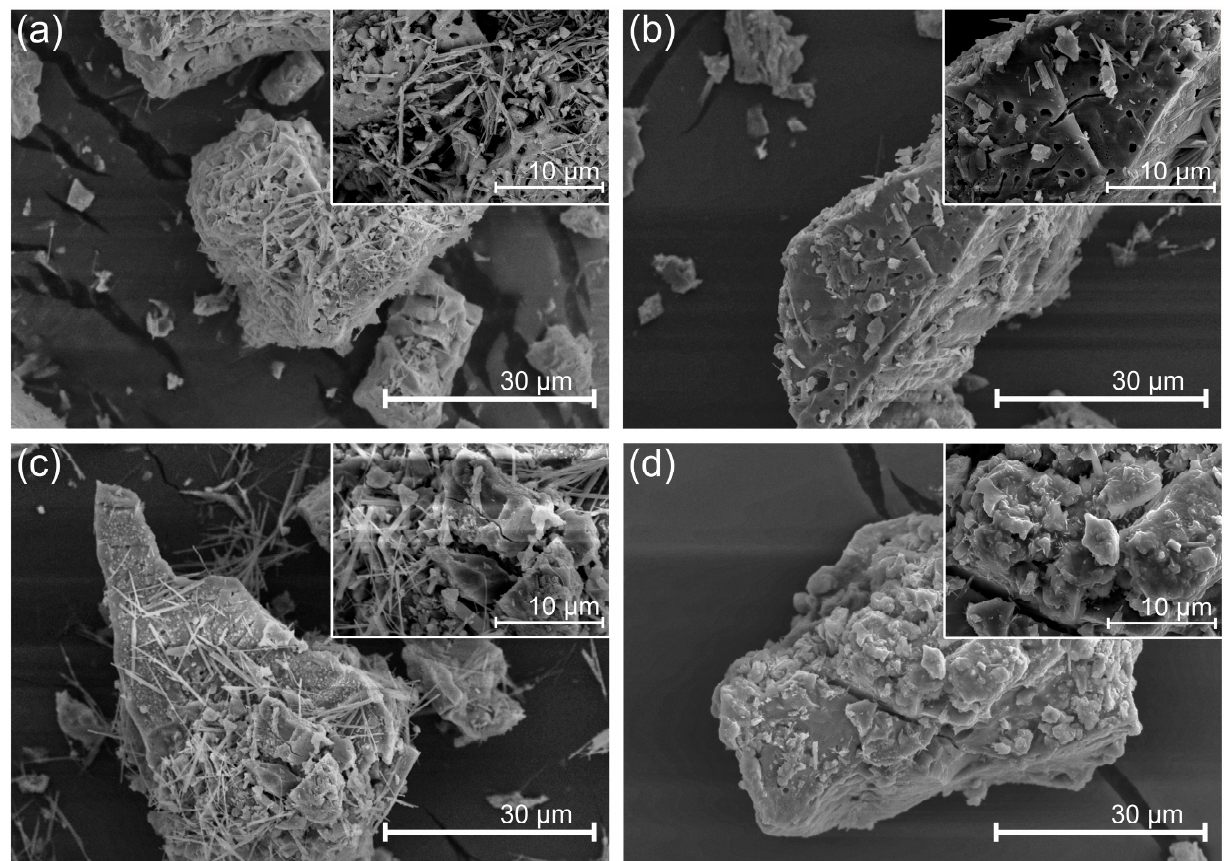
Figure 7. SEM micrographs of geopolymers: ( a ) Geo 16M; ( b ) Geo 20M; ( c ) Geo 25M; ( d ) Geo 30M.